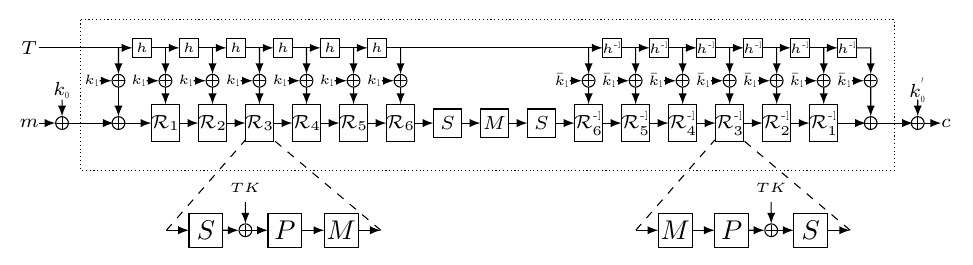
Figure 16: Illustration of the tweakable block cipher Mantis